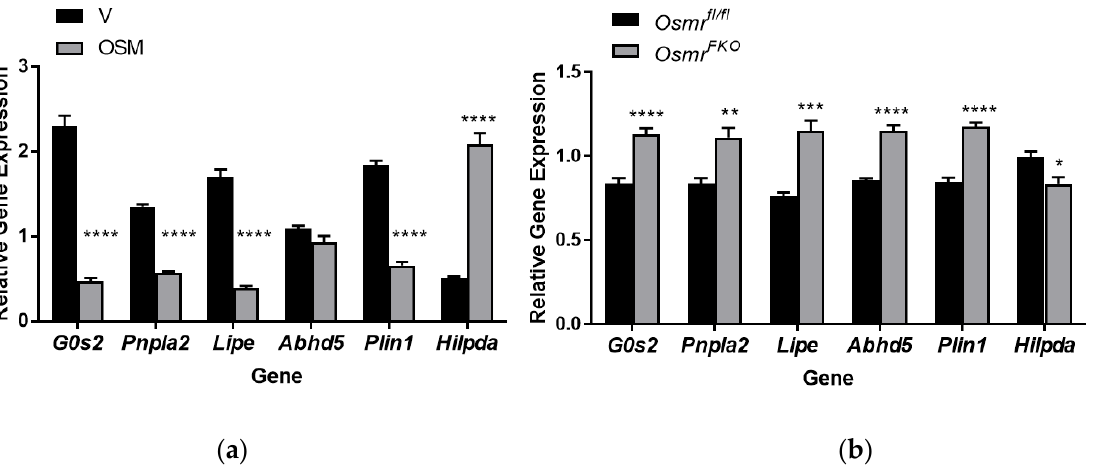
Figure 6. OSM exposure and OSMR loss differentially affect the expression of genes associated with lipolysis. ( a ) Fully differentiated 3T3-L1 adipocytes were exposed to 0.5 nM OSM in lipolysis incubation medium for 4 h. Cells were harvested for RNA synthesis and quantitative RT-PCR was performed for the genes indicated. ( b ) Primary adipocytes isolated from Osmr fl/fl and Osmr FKO mice were fully differentiated and then harvested for RNA synthesis. Quantitative RT-PCR was performed for the genes indicated. This experiment was conducted in duplicate on a single batch of adipocytes. Significant differences are denoted as follows: ** p < 0.01, *** p < 0.001, **** p < 0.0001 between groups.